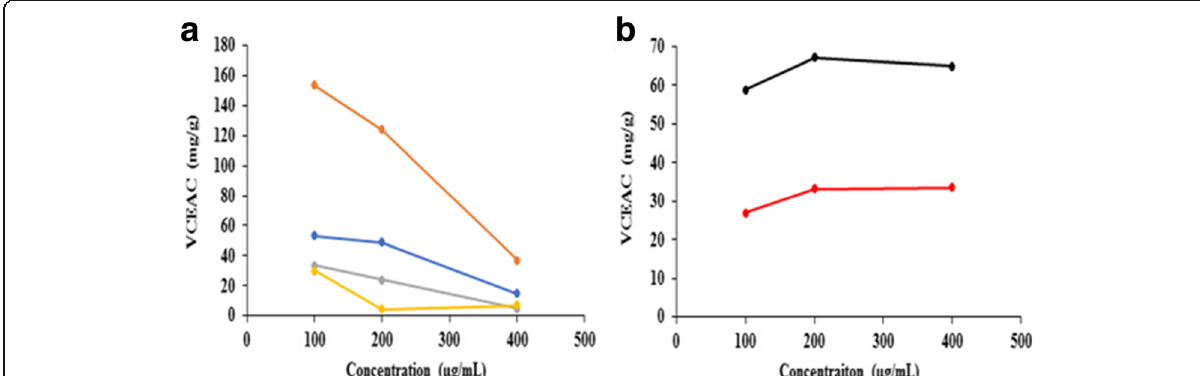
Fig. 4 a Comparison of total reducing power of methanolic extracts of Nyctanthes arbor-tristis leaves (orange), unripe fruit pulp of Aegle marmelos (grey), terminal meristem of Musa paradisiaca flower (blue) and ripe fruit pulp of Aegle marmelos (yellow) in terms of VCEAC at various concentrations. b Comparison of total reducing power of methanolic extracts of poly herbal formulations: PHF1 (black) and PHF2 (red) in terms of VCEAC at various